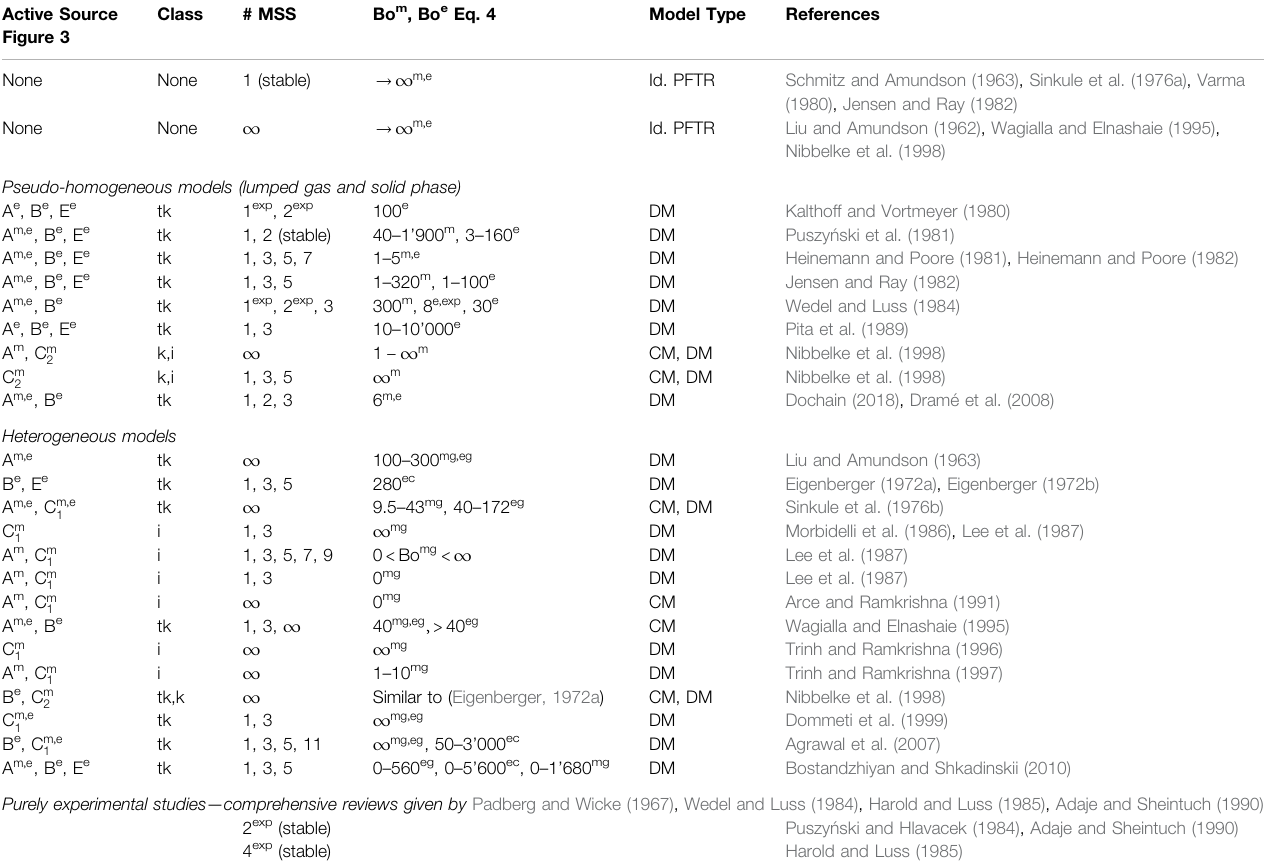
TABLE 1 | Review on multiplicity sources within fi xed-bed reactor models and experiments. Active Source Figure